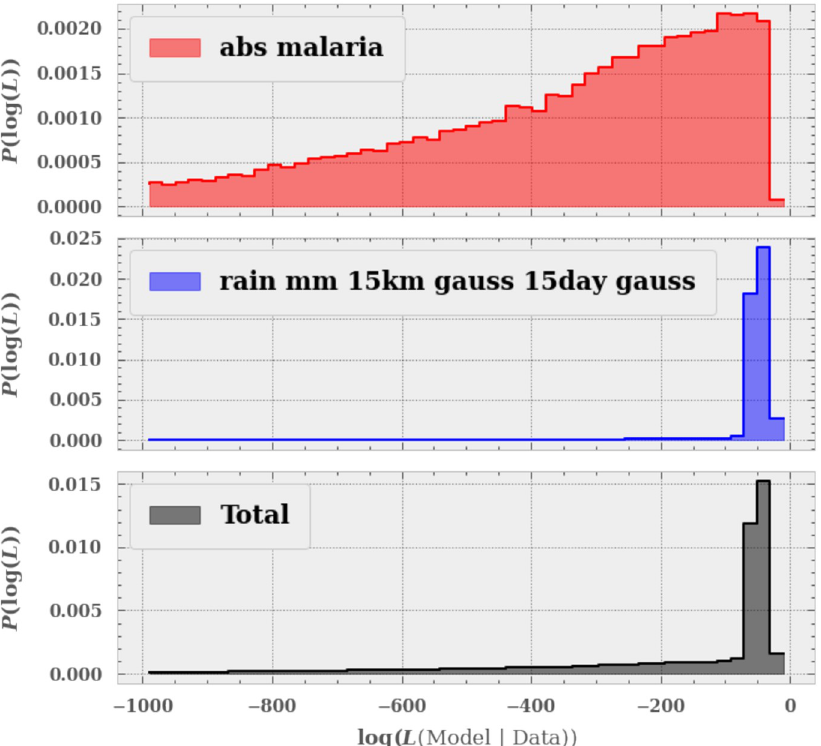
Fig 2. An example of how we select our models. We compare the observed data to each GP and generate a likelihood according to the type of data (whether it be Poisson or Gaussian). In this case the top panel showing the absolute number of cases of malaria is Poisson distributed, whereas the rain-fall is Gaussian. We then combined these likelihoods in to a final likelihood and select only those models that have an overall good